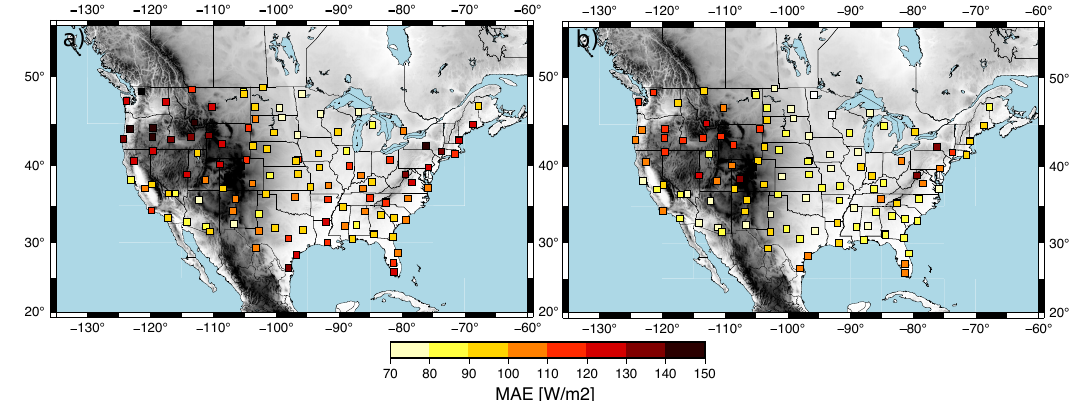
Figure 13. MAE of the GHI at the USCRN sites calculated using hourly analyses spanning the month of April 2018 for: ( a ) WRF-Solar and ( b )